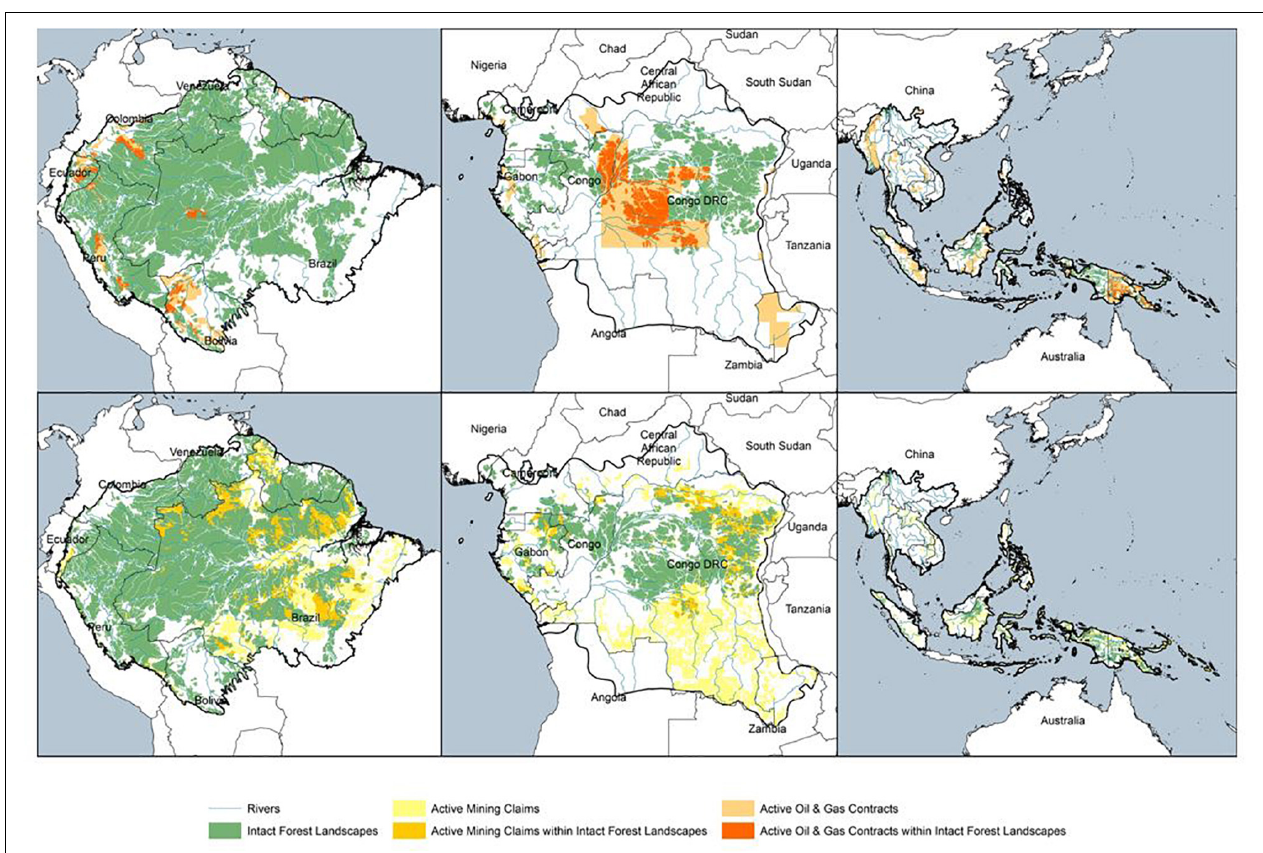
FIGURE 1 | The distribution of IFLs and oil and gas contracts (top) and mining leases (bottom) for the three regions of interest: South America (left), Central Africa (middle) and Asia-Pacific (right).